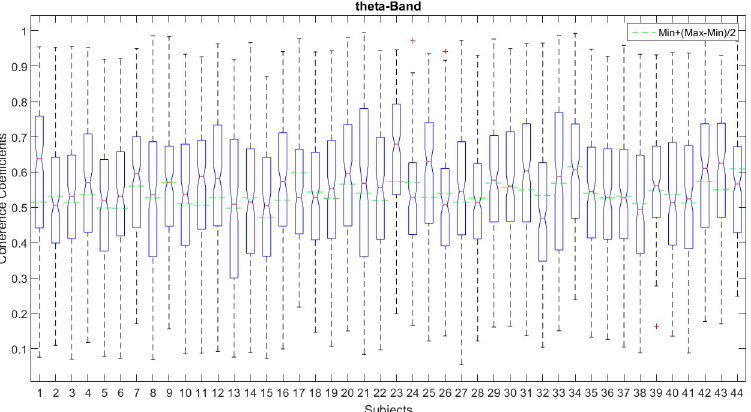
Fig 4. An example of the coherence coefficients distribution (CCD) by subject in θ band. The boxplots per subject indicate the 2nd and 3rd quartiles (blue box) which contain 50% of the sample, whiskers contain the 25% of lower and higher coherence values of the sample, the red line indicates the median value, and the green line represents the threshold which lies mostly in the 2nd and 3rd quartiles, taking into account more or less the 50% of the coherence values